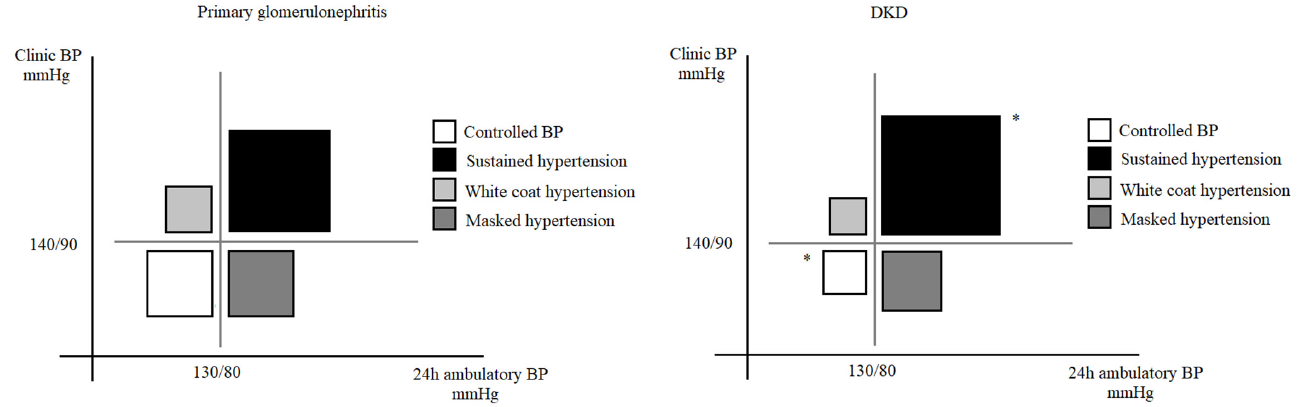
Figure 2. Proportions of different hypertension types through clinical and ambulatory blood pres- sure. Data are presented as numbers and proportions. Clinical hypertension—BP ≥ 140/90 mmHg.